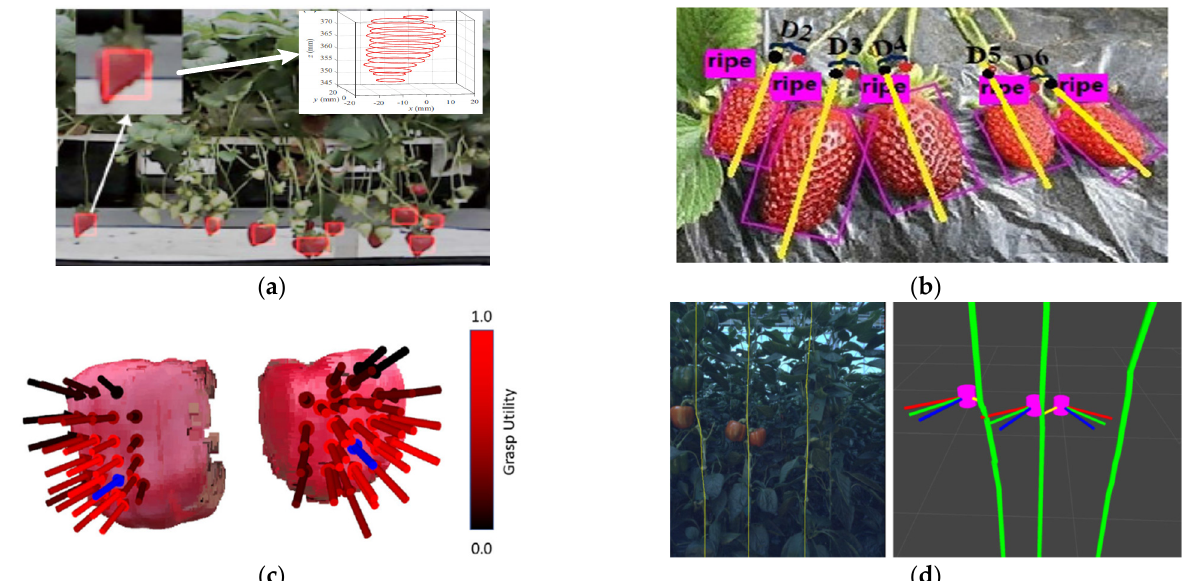
Figure 10. Method for obtaining spatial pose information of the fruit. ( a ) Shape reconstruction of strawberry fruit scanned by IR sensor (Photo: Reprinted with permission from Ref. [5]. 2017, Lehnert C.); ( b ) picking point localization in strawberry’s inclined stem (Photo: Reprinted with permission from Ref. [83]. 2020, Yu Y.); ( c ) grasp pose estimation according to pepper’s surface gradient (Photo: Reprinted with permission from Ref. [21]. 2020, Lehnert C.); ( d ) grasp pose estimation according to the position relationship between the main-stem and pepper fruit (Photo: Reprinted with permission from Ref. [22]. 2017, Bac C.W.).